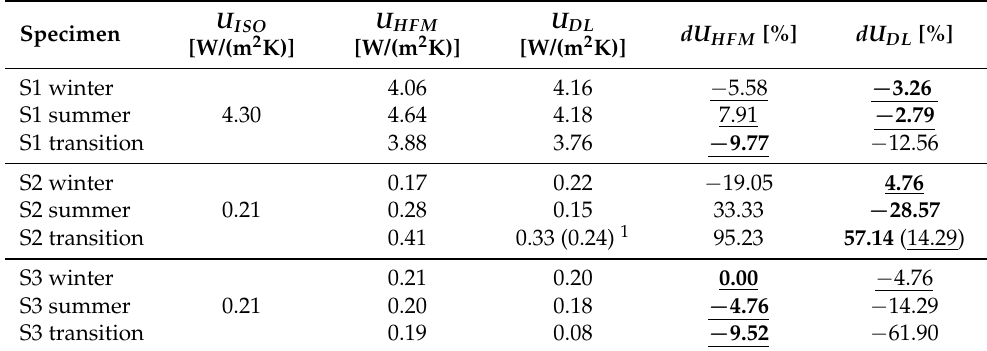
Table 4. Comparison of U -values calculated by the average method from the ISO 9869-1 applied on measured and predicted heat